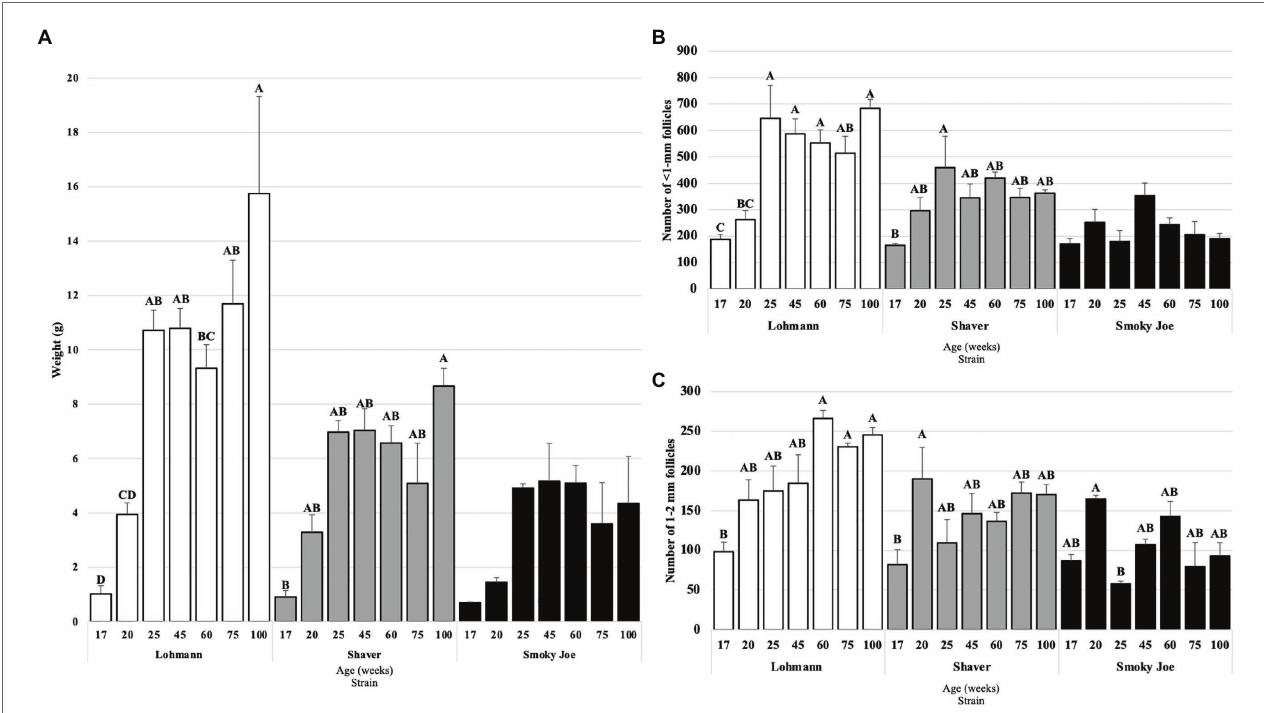
FIGURE 5 | Ovary weight (A) , as well as the number of <1-mm (B) and 1–2 mm follicles (C) in Lohmann, Shaver, and Smoky Joe hens at 17, 20, 25, 45, 60, 75, and 100 woa. (A) p -values for the sources of variation: Age, p < 0.0001; Strain, p < 0.0001; and Age * Strain, p = 0.0071 (B) Age, p < 0.0001; Strain, p < 0.0001; and Age * Strain, p = 0.0003. (C) Age, p < 0.0001; Strain, p < 0.0001; and Age * Strain, p = 0.0007. A,B,C,D Data points lacking the common superscript differ significantly within the ages of each strain, while no superscript indicates no difference from any other time point in that